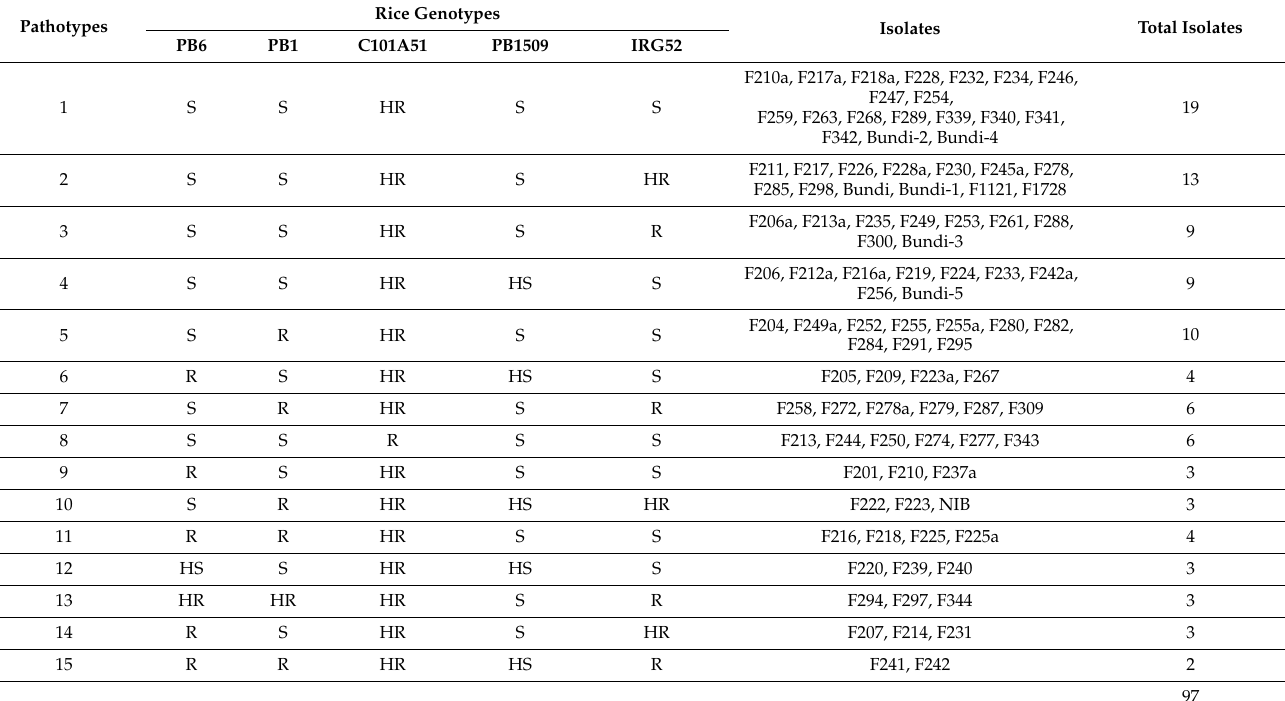
Table 3. Pathotype classification of Fusarium fujikuroi isolates based on pattern of disease reaction in rice genotypes differing in their